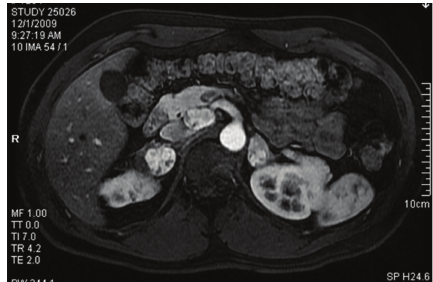
Figure 3: Arterial phase T1-weighted image in the axial plane fol- lowing intravenous contrast depicts hypervascular adrenal masses on both sides and an approximately 3cm hypervascular mass in the uncinate process of the pancreas consistent with a neuroendocrine